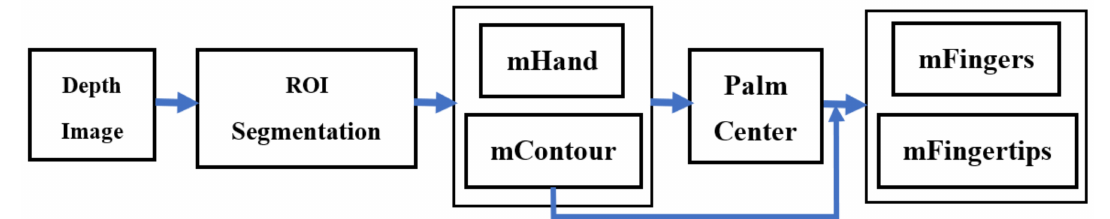
Figure 1. The flowchart of the hand segmentation and finger